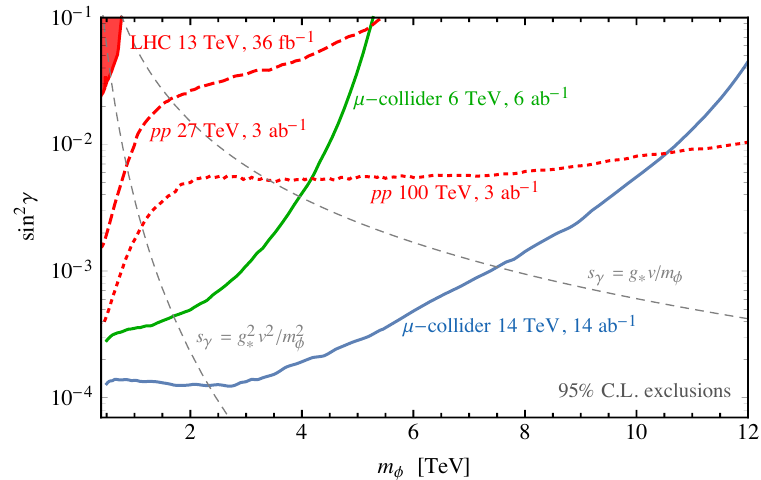
Figure 7. Sensitivies of very high energy hadron and muon colliders at 95% C.L. in the plane ( m (cid:30) ; sin 2 (cid:13) ). The red lines show the reach in (cid:30) ! ZZ of HE-LHC at p FCC-hh at s = 100 TeV (dotted), both with 3 ab (cid:0) 1 . The solid lines show the reach in (cid:30) ! hh (4 b ) p of a muon collider at s = 6 TeV with 6 ab (cid:0) 1 (green), and at We have (cid:12)xed BR (cid:30) ! hh = BR (cid:30) ! ZZ = 25%. The grey dashed lines show two possible scalings